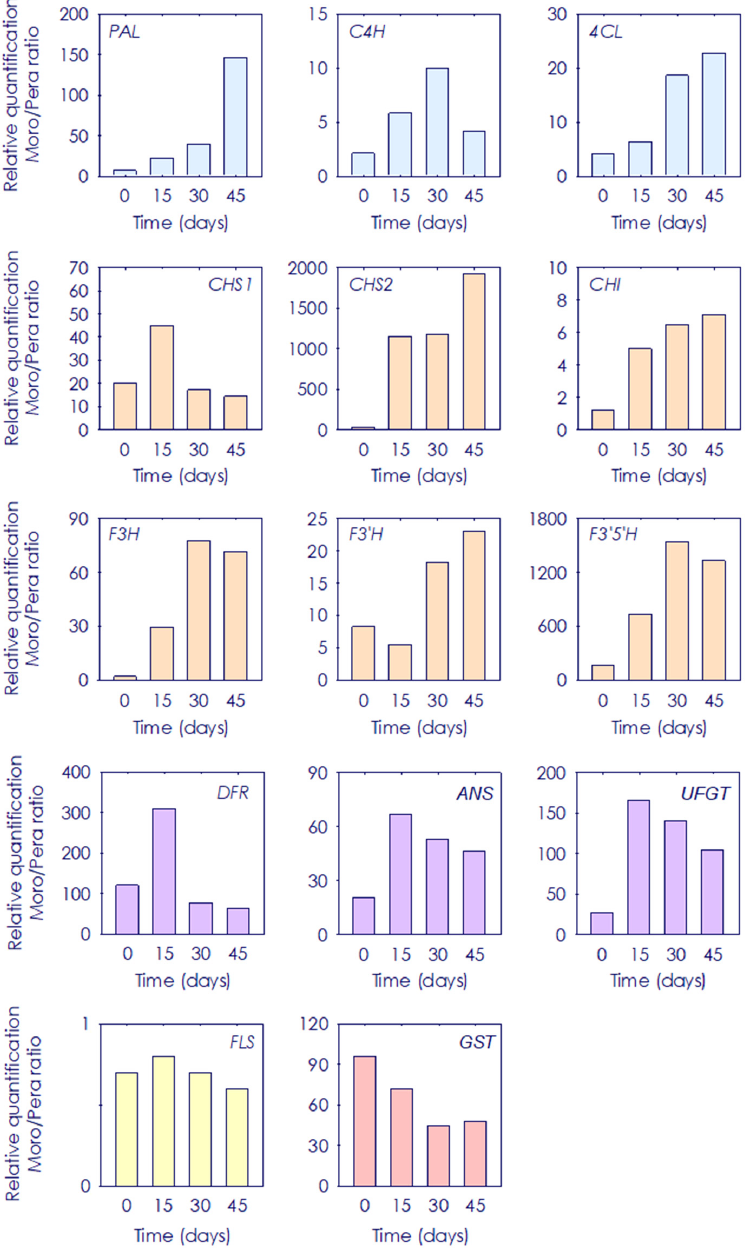
Figure 7. Ratio of the relative expression of phenylalanine ammonia-lyase ( PAL ), cinnamate 4-hydroxylase ( C4H ), 4-hydroxy-cynnamoyl CoA ligase ( 4CL ), chalcone synthases 1 and 2 ( CHSs ), chalcone isomerase ( CHI ), flavonoid 3-hydroxylase ( F3H ), flavonoid 3’5’-hydroxylase ( F3’5’H ), flavonol synthase ( FLS ), di- hydroflavonol 4-reductase ( DFR ), anthocyanidin synthase ( ANS ), uridine diphos-phate-glucose:flavonoid 3-O-glucosyltransferase ( UFGT ) and glutathione-S-transferase ( GST ) in the pulp of Moro vs. Pera oranges during storage for 0, 15, 30 and 45 days. Blue, and orange bars indicate genes involved in the general phenypropanoids and flavonoids, respectively. Yellow and purple bars indicate genes involved in the flavonols and anthocyanins biosynthesis, respectively. Red bars belong to those genes involved in the anthocyanin transport.